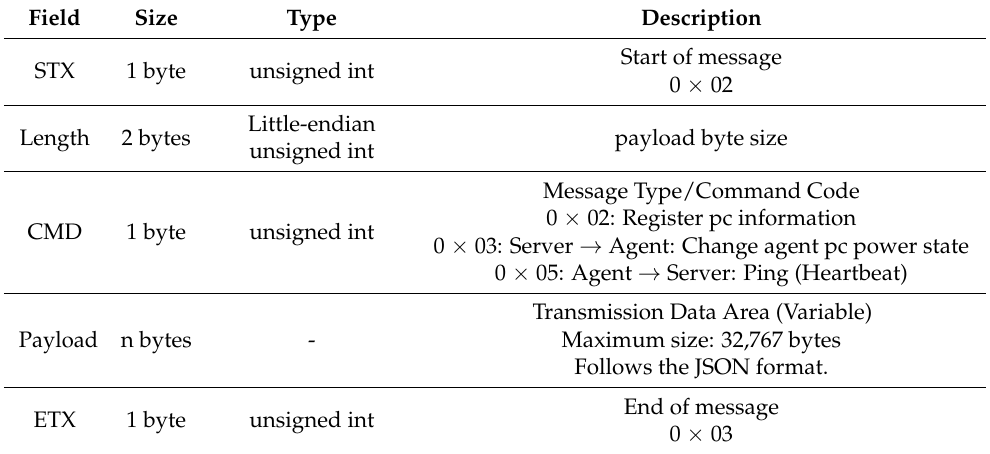
Table 10. Communication protocol details.